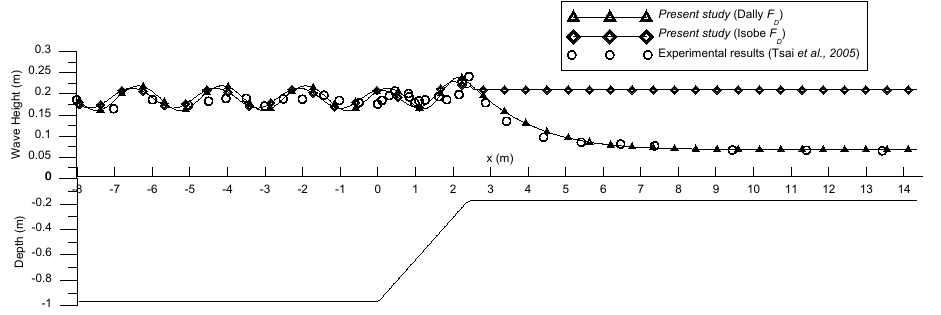
Figure 16. Wave heights for breaking and dissipation of wave by a slope of 1/3 with varying formulas of energy dissipation factors [25,27,29].